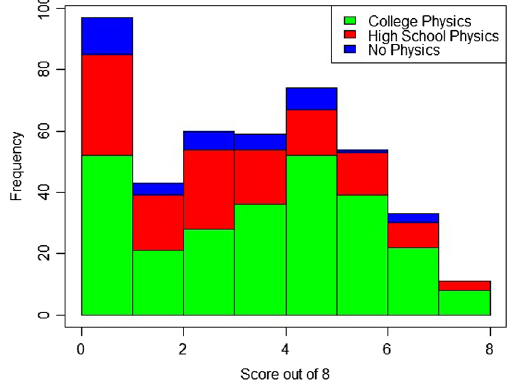
FIG. 5. Subscore on test of understanding vectors for students with various physics backgrounds. Green is students who have taken college-level physics (AP, N ¼ 258 ), red is for students who have taken high school physics ( N ¼ 135 ), and blue is for students who have taken no physics ( N ¼ 38